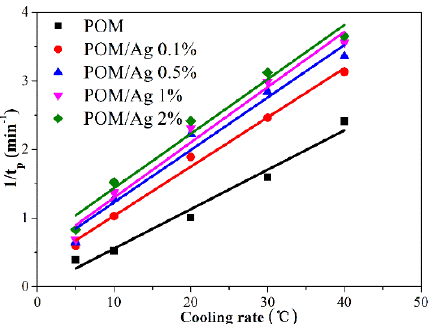
Figure 8. Reciprocal half-time of crystallization versus cooling rate plot of POM and POM/Ag nanocomposites.